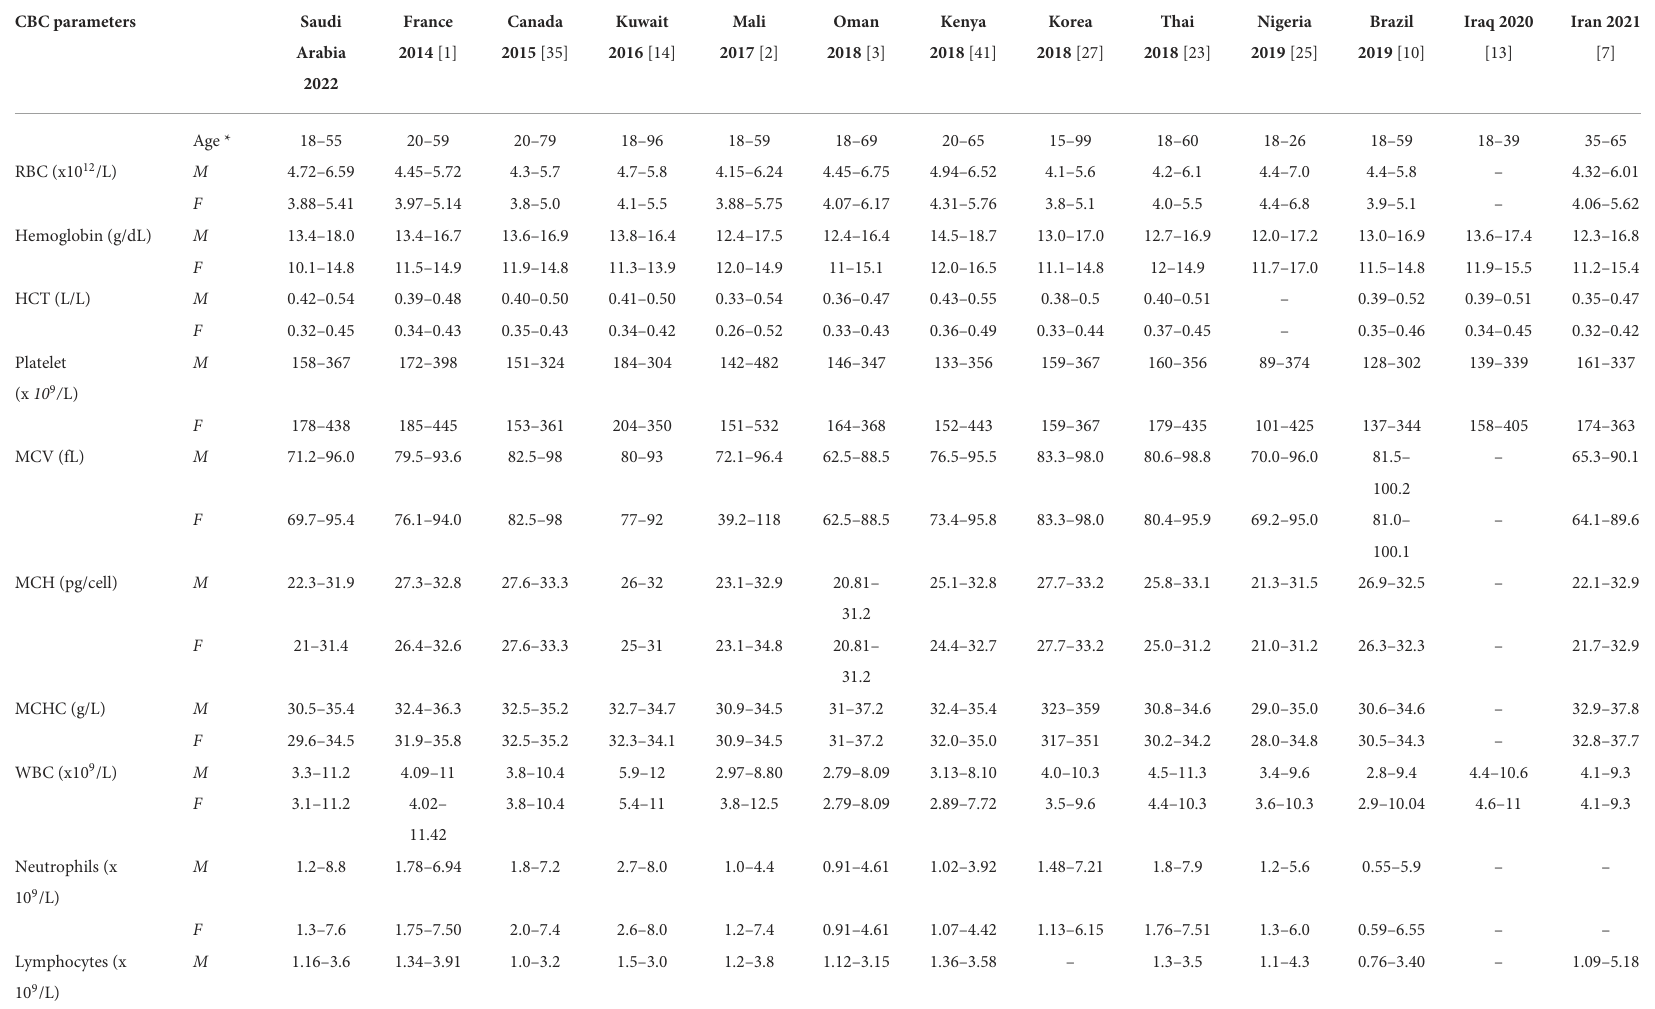
TABLE 6 Comparison of CBC parameters reference intervals across reported